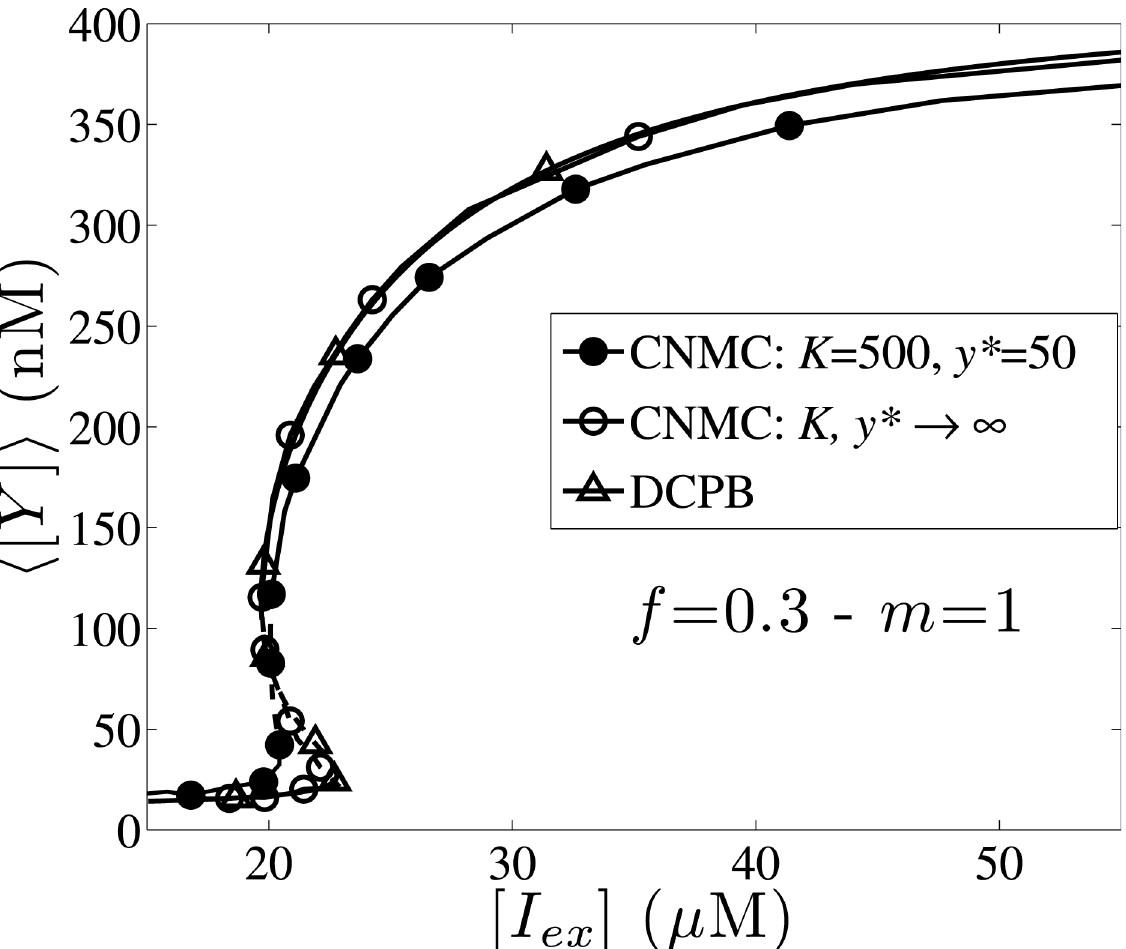
Fig 13. Effect of intrinsic noise for low single cell division rates. Steady state of average expression level, h [ Y ] i , as a function of the external IPTG concentration for the case of f = 0.3 and m = 1. The lines with full circles correspond to the CNMC model with K = 500 and y * = 50; the lines with open circles correspond to the CNMC model neglecting intrinsic noise effects, and the black lines to the DCPB model. Parameter set values: π = 0.03 and κ = 0.05. CNMC simulations are carried out with N = 10,000